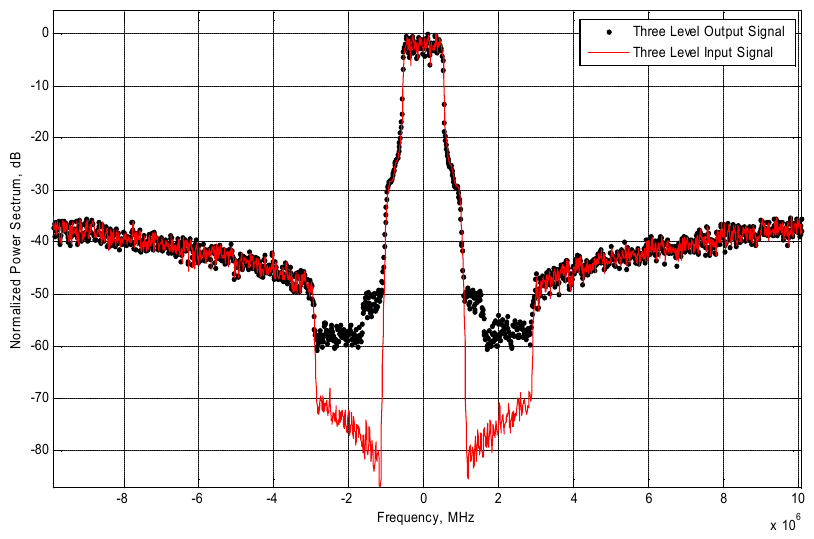
Figure 7. Normalized input and output three-level CxDSM signal.